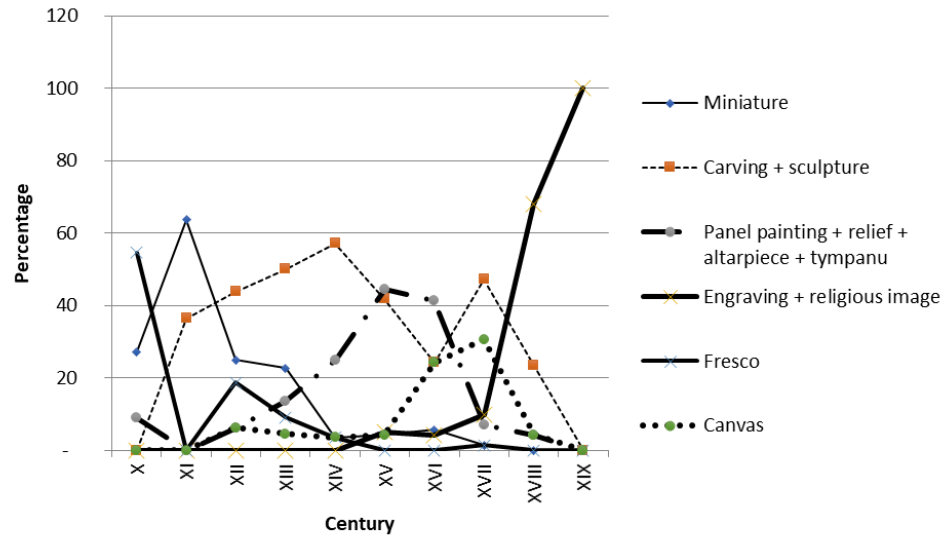
Figure 2. Different types of mediums used in representations of Mary by century. Source: Authors’ elaboration based on Trens elaboration based on Trens (1946).